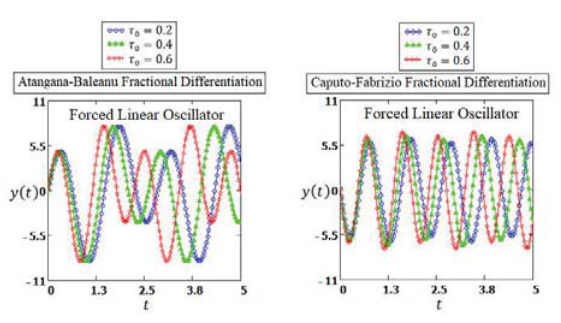
Figure 2: Profile of displacement for varying damping ratio response curves with parametric values F = 0.3, ω = 1.2, t = 2 s , η 1 = η 2 = 0.7 subject to Atangana-Baleanu and Caputo-Fabrizio fractional differential operators.